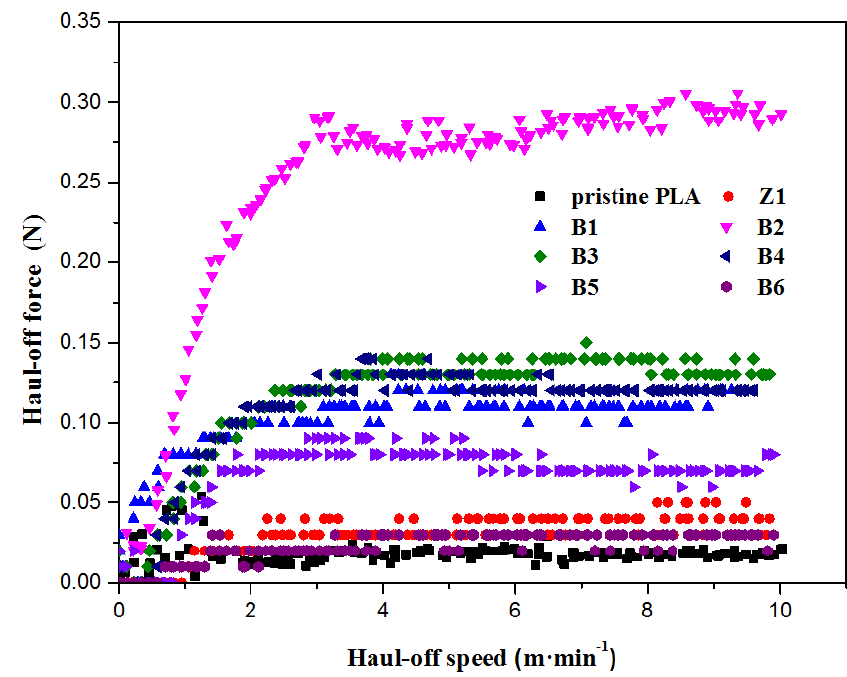
Figure 12. Haul-off force vs. Haul-off speed of PLA samples at 170 ◦